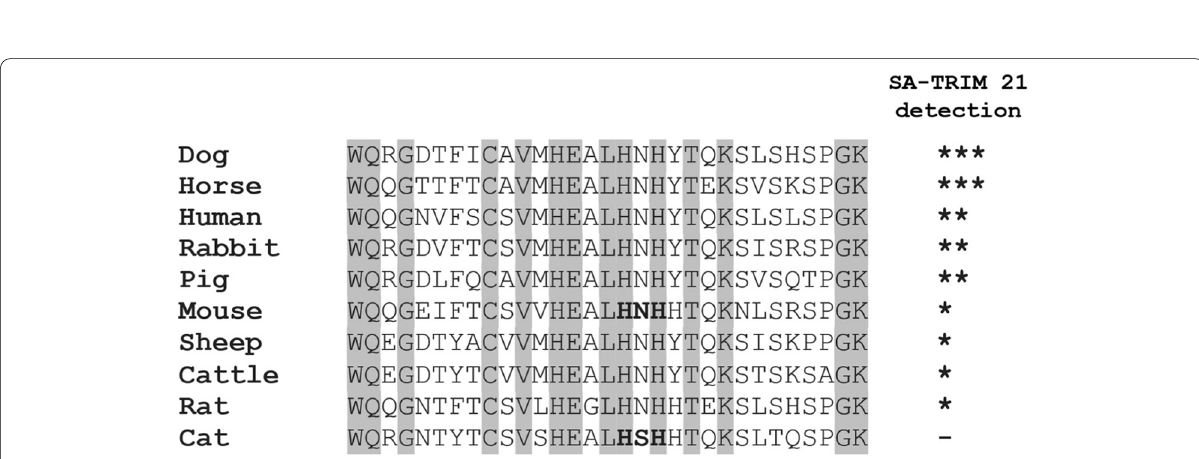
Fig. 7 The figure depicts the alignment of IgG heavy chain Fc regions from different mammalian species. The residues in gray are conserved among all sequences. The residues marked in bold represent the Mouse IgG Fc hot spots (H433, N434, and H435) necessary for binding to TRIM21 identified in previous studies [6]